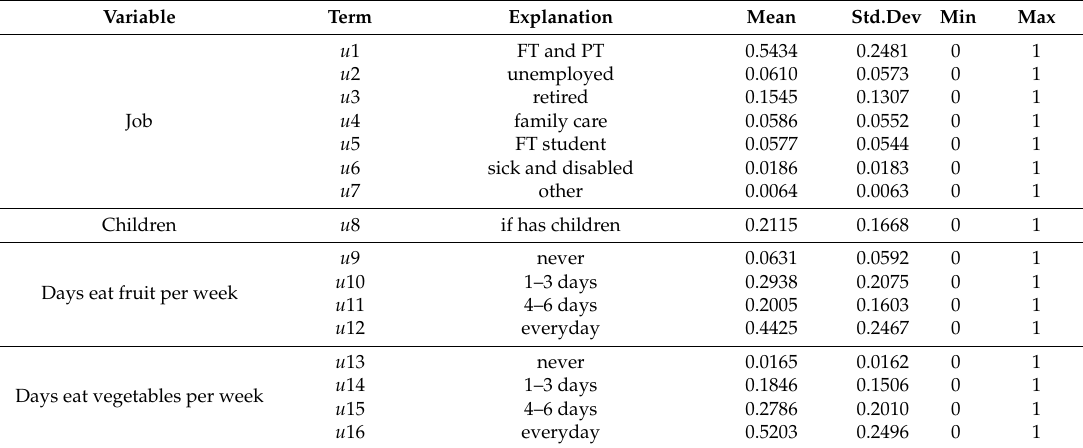
Table 1. Statistic Description of UKUS